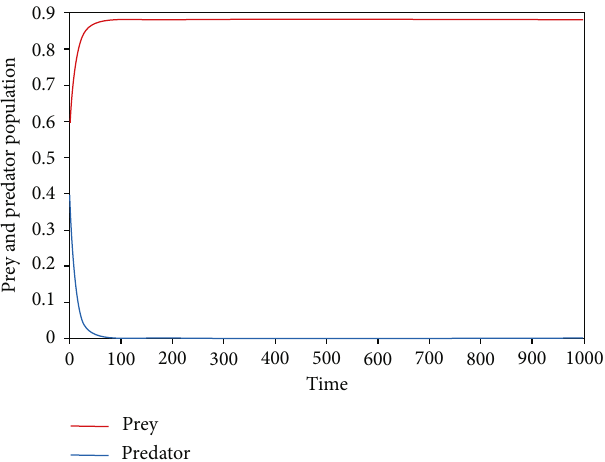
1 with parametric value as in Table 2